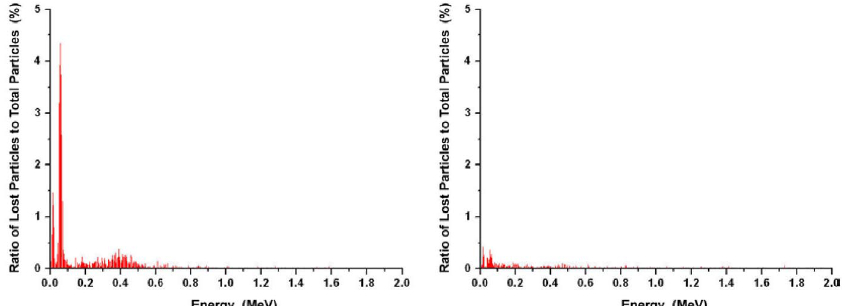
FIG. 5. (Color) Ratio of lost particles to total particles versus energy (left: before optimization; right: after